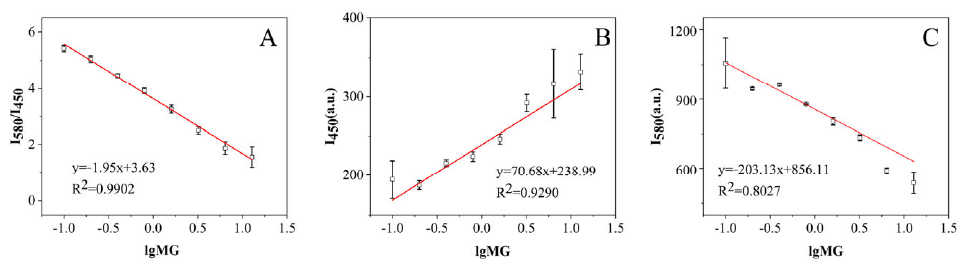
Figure 4. ( A ) The linear response of the ratio of I 580 /I 450 to the logarithm of the concentration of MG. ( B ) The linear response of I 450 to the logarithm of the concentration of MG. ( C ) The linear response of I 580 to the logarithm of the concentration of MG.